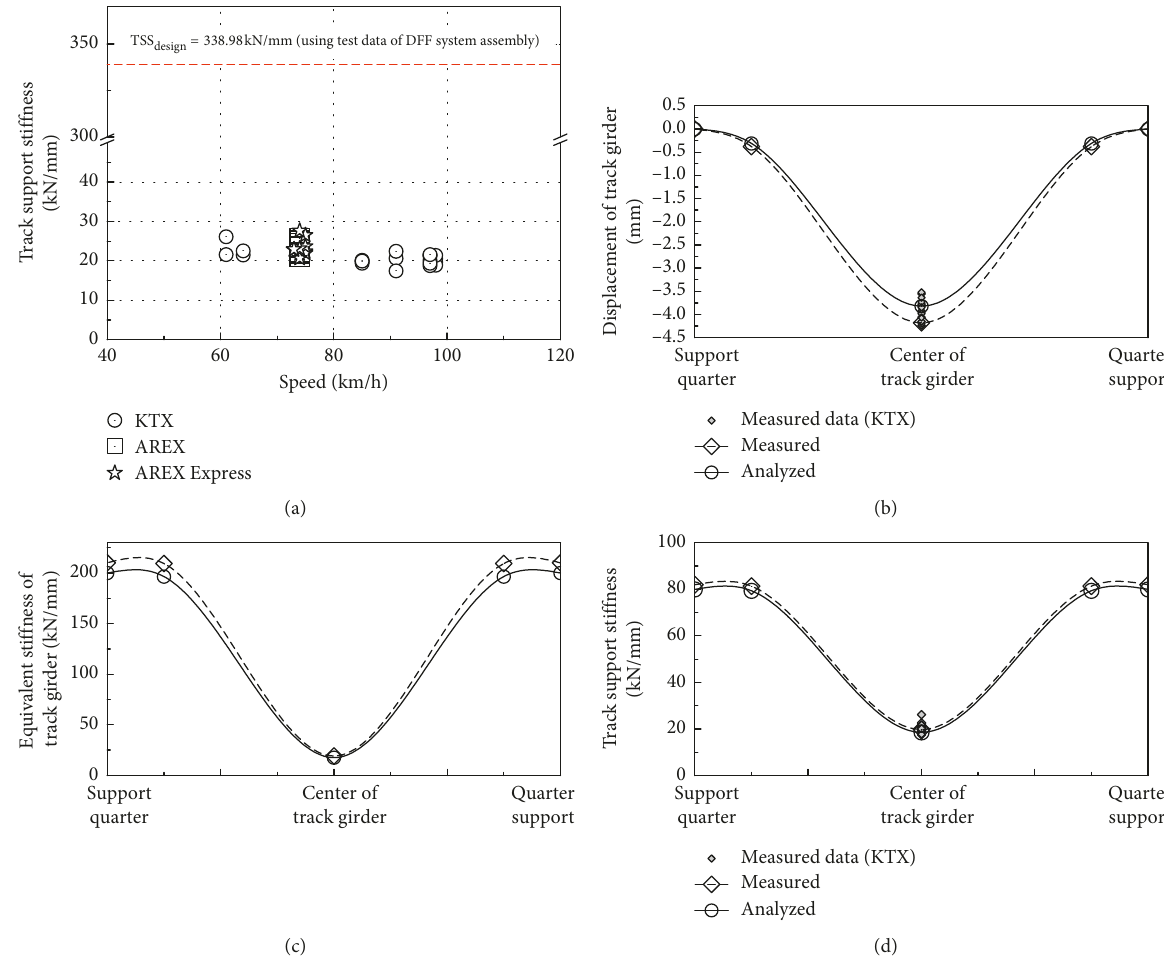
Figure 5: Spring stiffness model of the direct fixation track at the rail supporting points. k k track girder � equivalent stiffness of the track girder